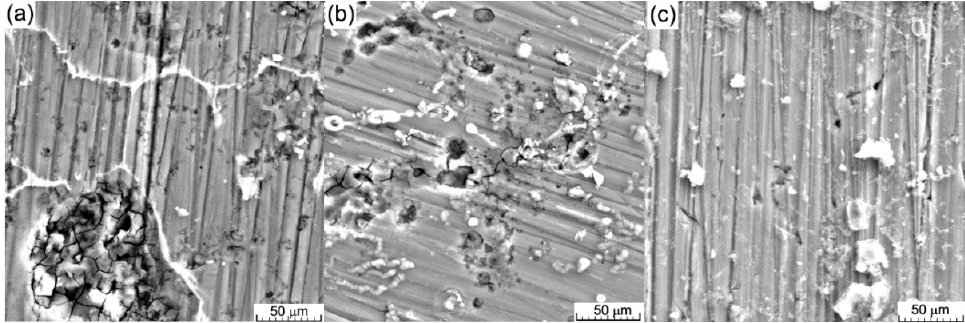
Figure 10. SEM image of the surface after the electro-corrosion test in SBF solution: ( a ) MgCa0.5Zn, ( b ) MgCa1.5Zn, and ( c ) MgCa3Zn.